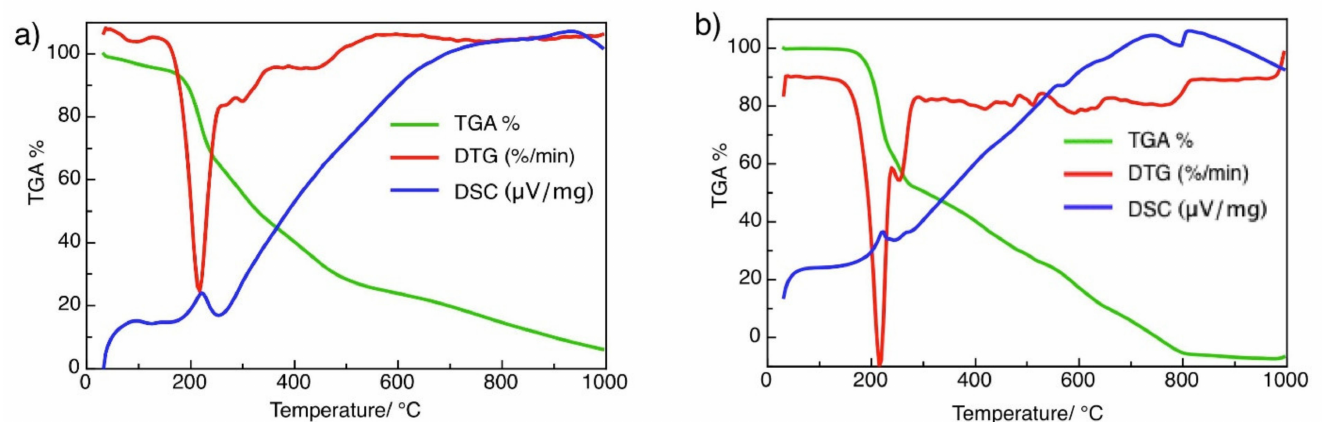
Figure 2. TGA plot of ( a ) BU and ( b ) BUChA